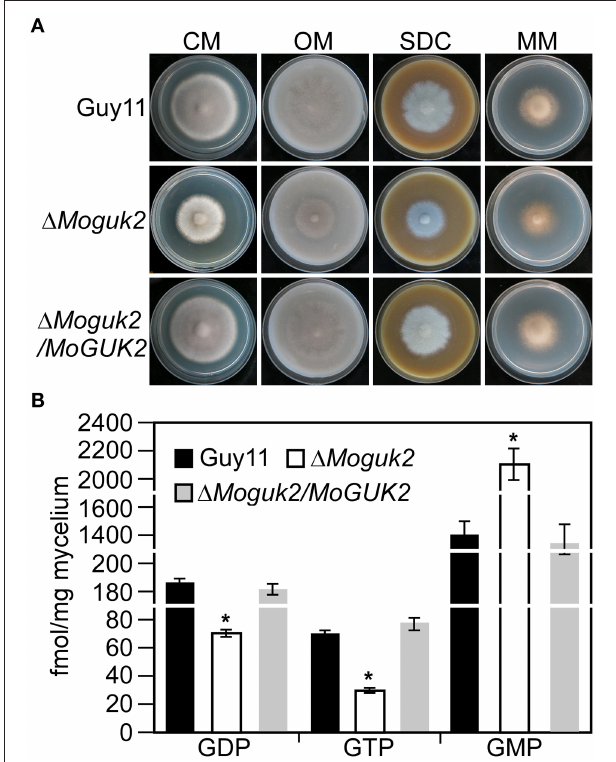
FIGURE 3 | The 1 Moguk2 mutant decreased vegetative growth and intracellular GDP, GTP level, and increased GMP level. (A) Colony morphology was examined on CM, SDC, OM, and MM ager plates, and photographed after culture at 28 ◦ C in darkness for 7 days. (B) Intracellular GDP, GTP, and GMP measurement. Error bars are standard deviations and asterisks represent significant differences at P < 0.01.